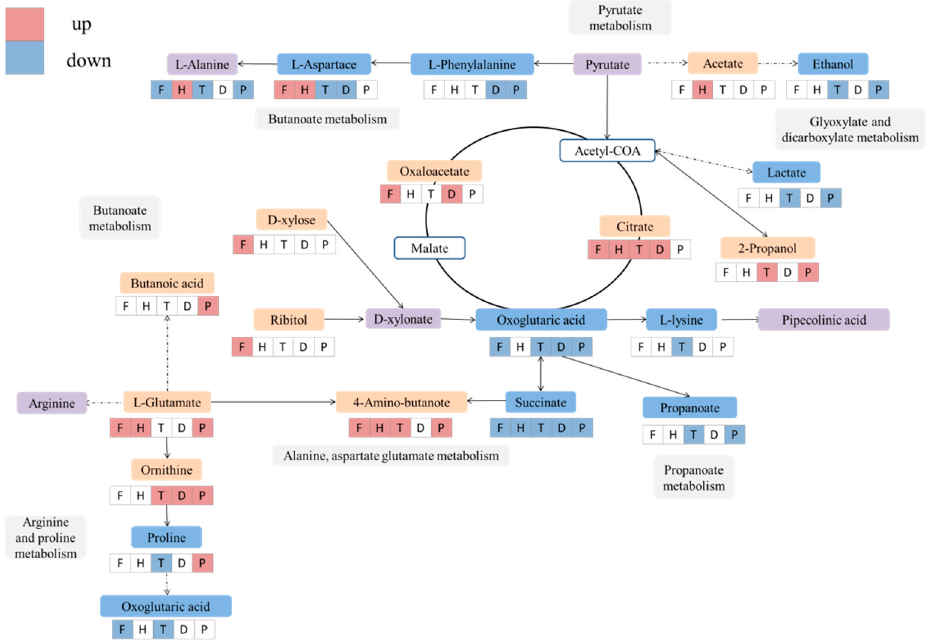
Figure 8. Effects on metabolic pathways of wine fermentation under the treatment of F, H, T, D, P. Note: F, flutriafol; H, hexaconazole; T, tebuconazole; D, difenoconazole; P,